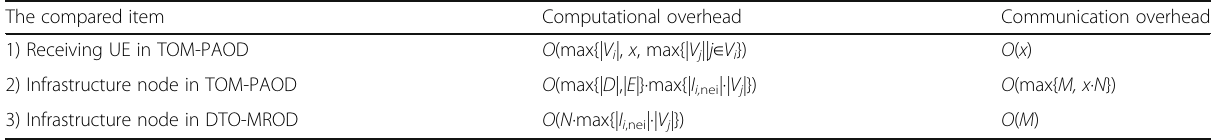
Table 1 The complexity comparison between TOM-PAOD and DTO-MROD The compared item